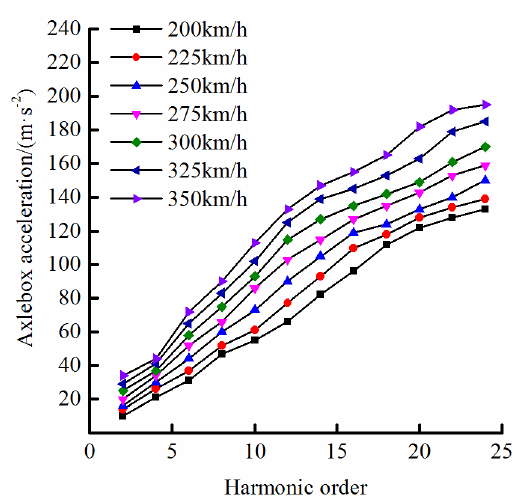
Figure 6. Axle-box acceleration as a function of harmonic order of polygonized wheel (i.e., the number of wavelengths around the wheel) for several train speeds.